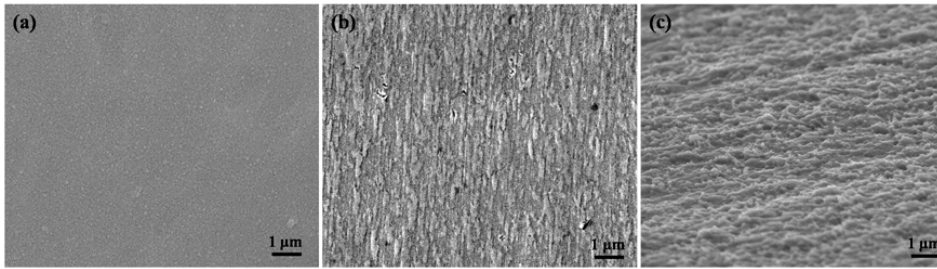
Figure 1. Superficial field ‐ emission scanning electron microscope (FE ‐ SEM) images of the control and plasma ‐ oxidized samples: ( a ) the control sample (top ‐ view); ( b ) the sample plasma ‐ oxidized at 160 W for 30 min (top ‐ view); and ( c ) the sample plasma ‐ oxidized at 200 W for 30 min (side ‐ view). The side ‐ view image provides clearer surface morphology difference between the control sample and the plasma ‐ oxidized sample.